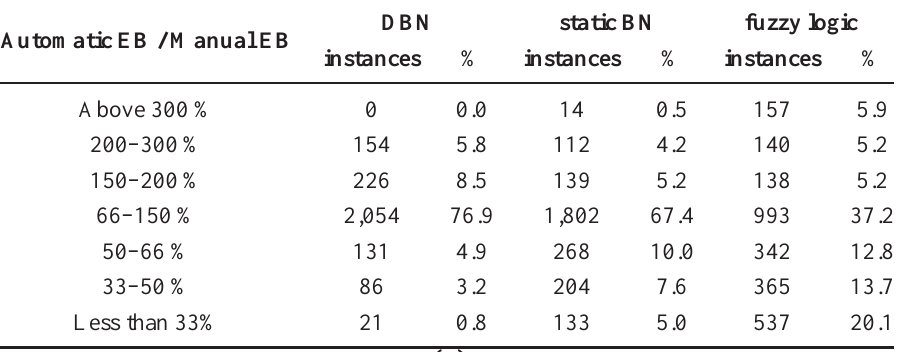
Table 4. A comparison of the uncertainty measures of the DBN (section 6), static BN [15] and fuzzy logic assessment systems [14] expressed as a histogram of the ratio between the automatic quality metrics and manual error bars across a test-set of 2,672 samples for the conductivity sensors in Sullivans Cove. ( a ) Conductivity sensor situated at a depth of 1 m; ( b ) Conductivity sensor situated at a depth of 10